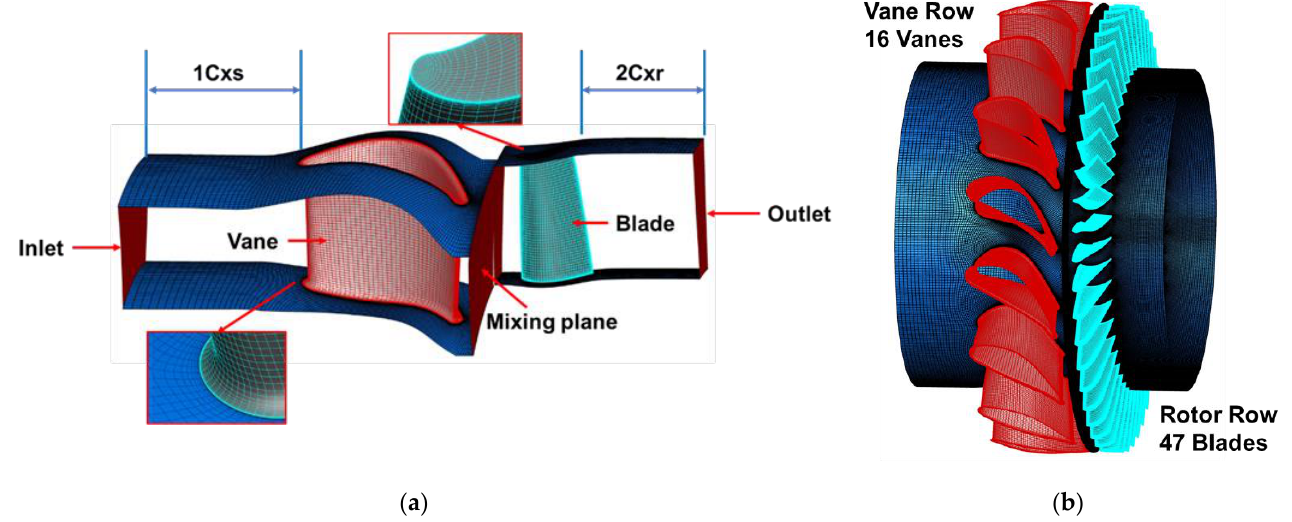
Figure 2. Computational mesh of the turbine stage: ( a ) Single-passage; ( b ) Full annulus.